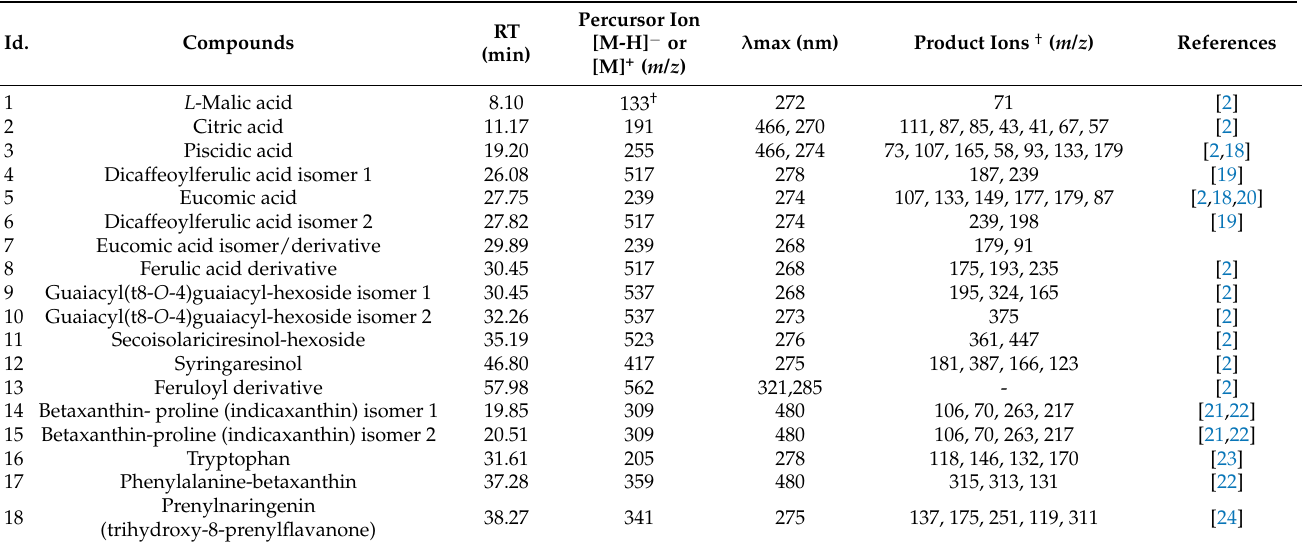
Table 2. Retention time (RT) and characteristic MS ions of phytochemical compounds identified in prickly pear fruits during cold and shelf life